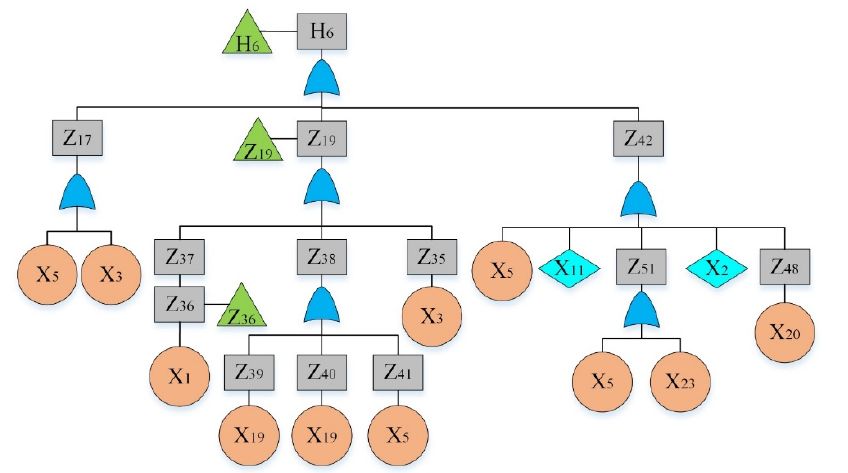
Figure 7. Fault tree of a hydraulic system: sub-tree V.